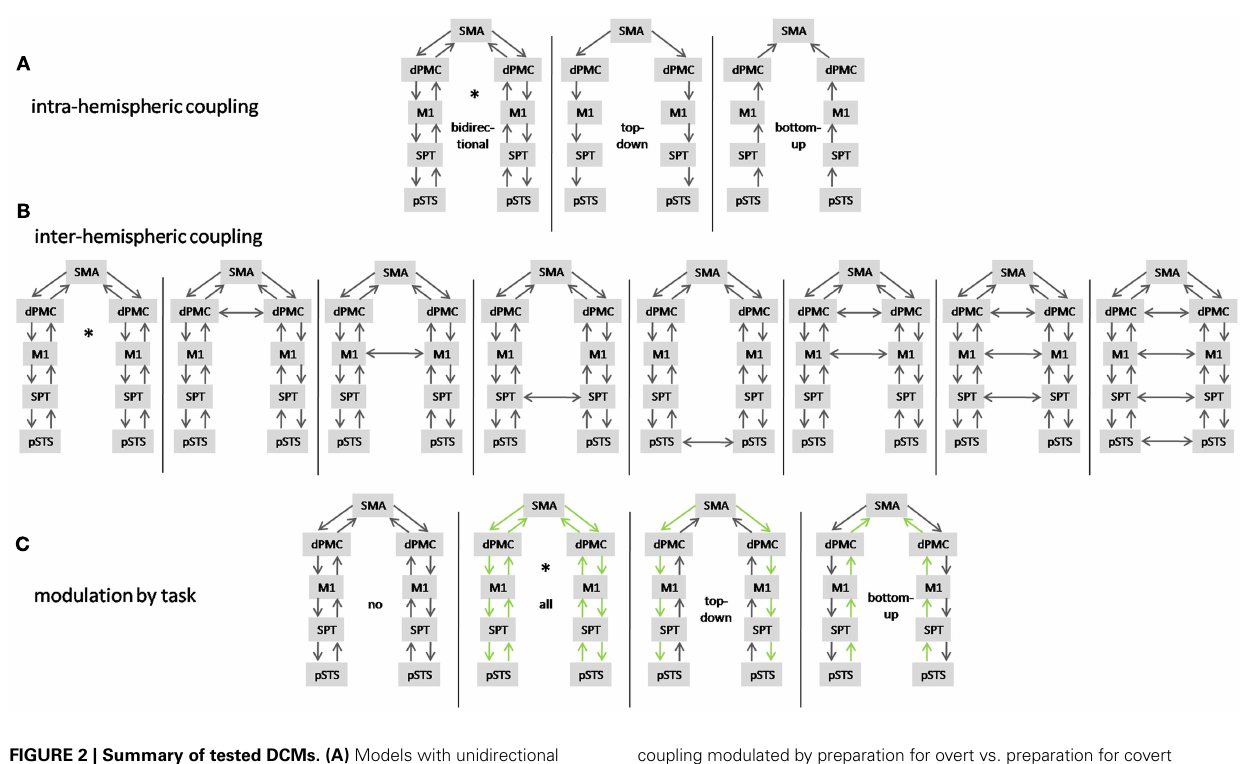
FIGURE 2 | Summary of tested DCMs. (A) Models with unidirectional (top-down, bottom-up) and bidirectional coupling. (B) Models with different interhemispheric coupling and (C) models with different